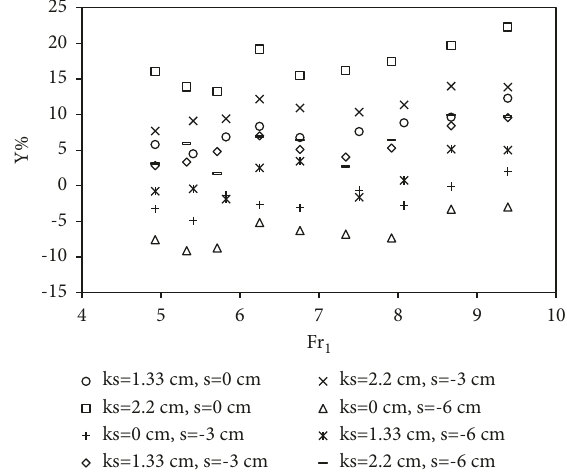
with Fr 1 for different 1